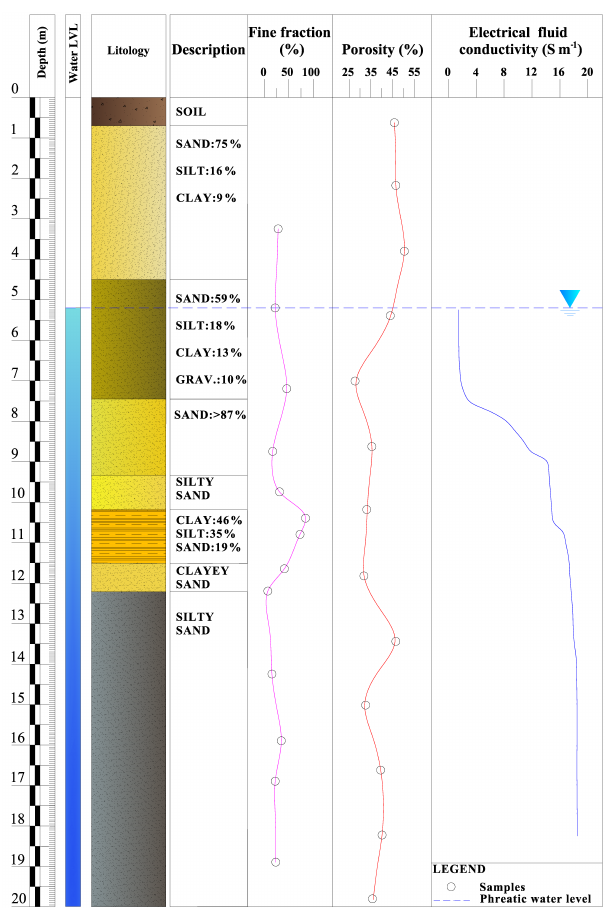
Figure 2. Generalized stratigraphy log from the five drilled bore- holes including lithology, percentage of fine fraction, and porosity from samples as well as electrical conductivity of borehole fluid. The water table lies at 5.2mb.g.s.